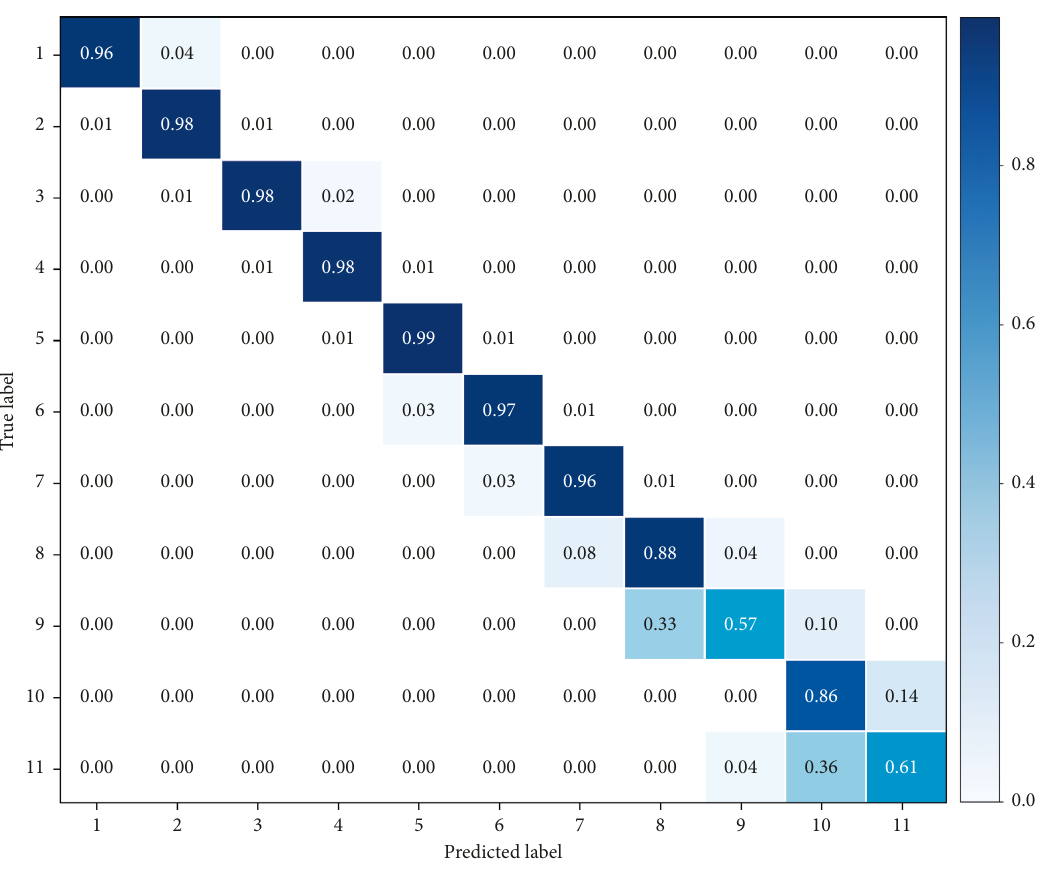
Figure 9: AQHI confusion matrix of